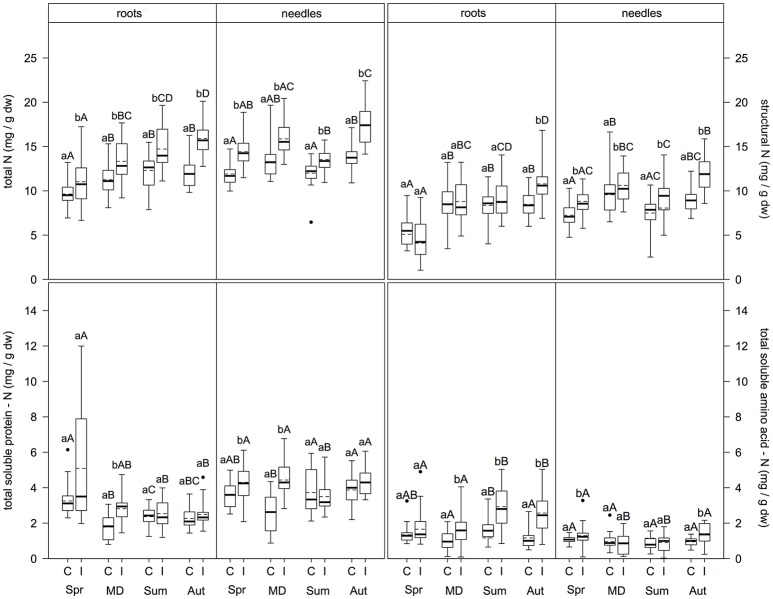
Total N, structural N, soluble protein-N, and soluble amino acid-N content in fine roots and needles (mg/g dw) at infested and non-infested pine forests over the vegetation period. I, infested; C, control; MD, main defoliation. Box plots show means (dotted lines) and medians (straight lines) (n = 12 for roots, n = 8 for needles for each plot). Whisker extension equals 3x interquantile range distance. Different small letters indicate significant differences between infested and control plots within one sampling time (p ≤ 0.050). Different capital letters indicate significant differences between the sampling times within one treatment (p ≤ 0.050).